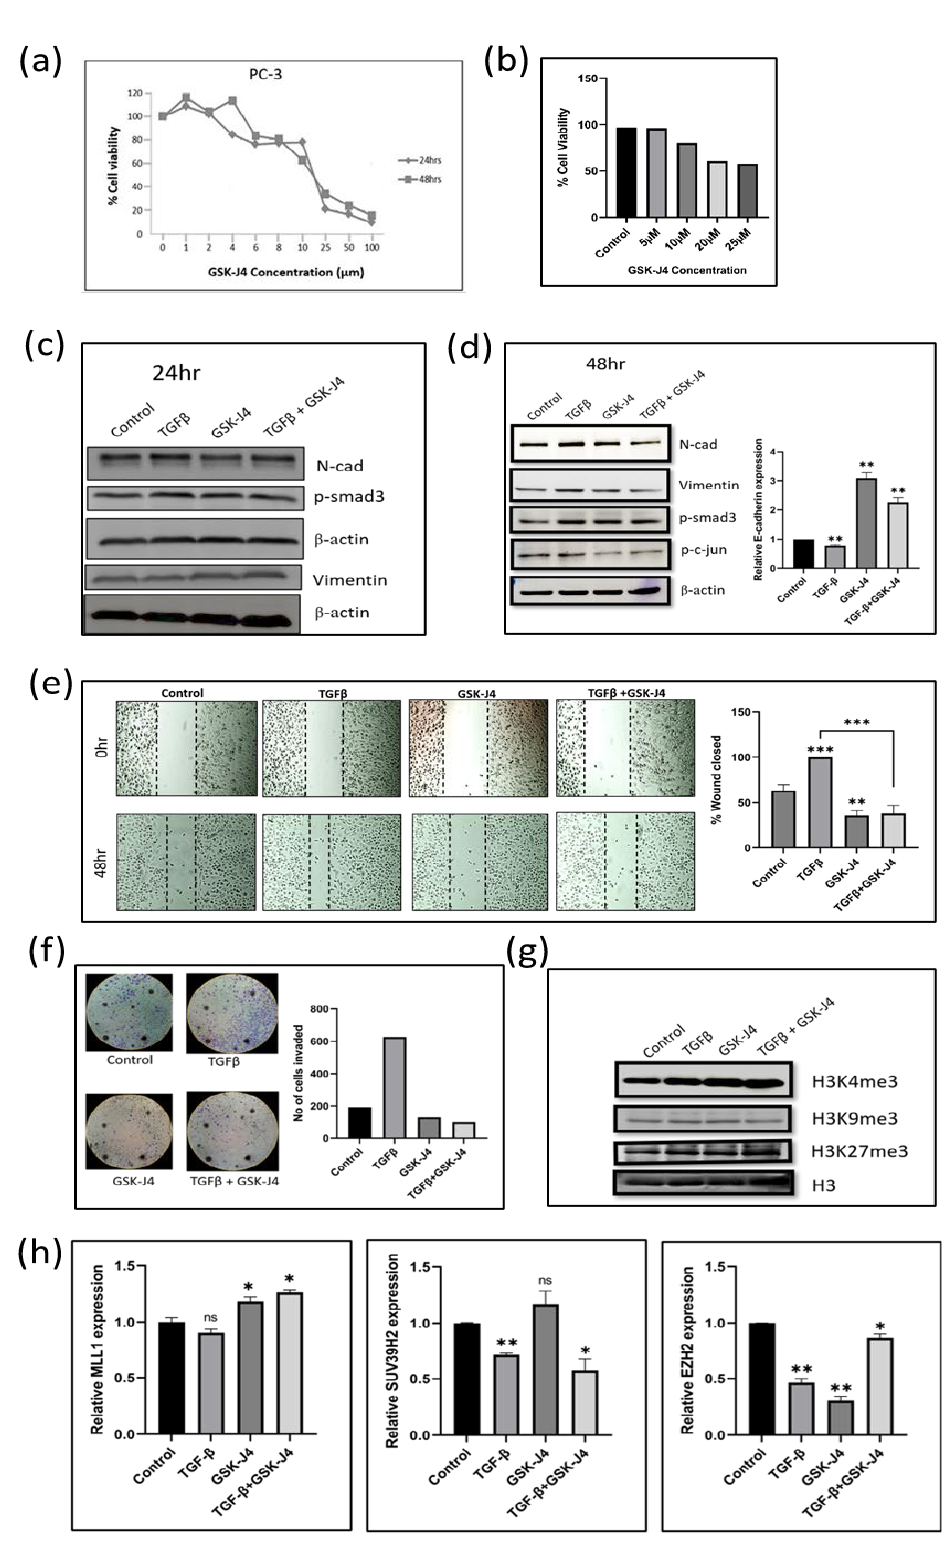
Figure 1. ( a ) Graph shows results of MTT assay in the PC3 cell line to determine the effect of GSK-J4 on cell proliferation. DMSO was taken as the vehicle control. ( b ) The bar graph represents the effect of GSK-J4 on cell viability based on Trypan blue dye uptake in PC-3 cells. DMSO was taken as the vehicle control. ( c ) Western blot image of N-cadherin, p-smad, and vimentin in PC-3 cell line after 24 h of treatment. β -Actin was taken as the loading control. ( d ) Western blot image of N-cadherin, p-smad3, p-c-jun, and vimentin in PC- 3 cell line after 48 h of treatment. β -Actin was taken as the loading control. The graph represents the relative quantification of E-cad mRNA in PC3 cells